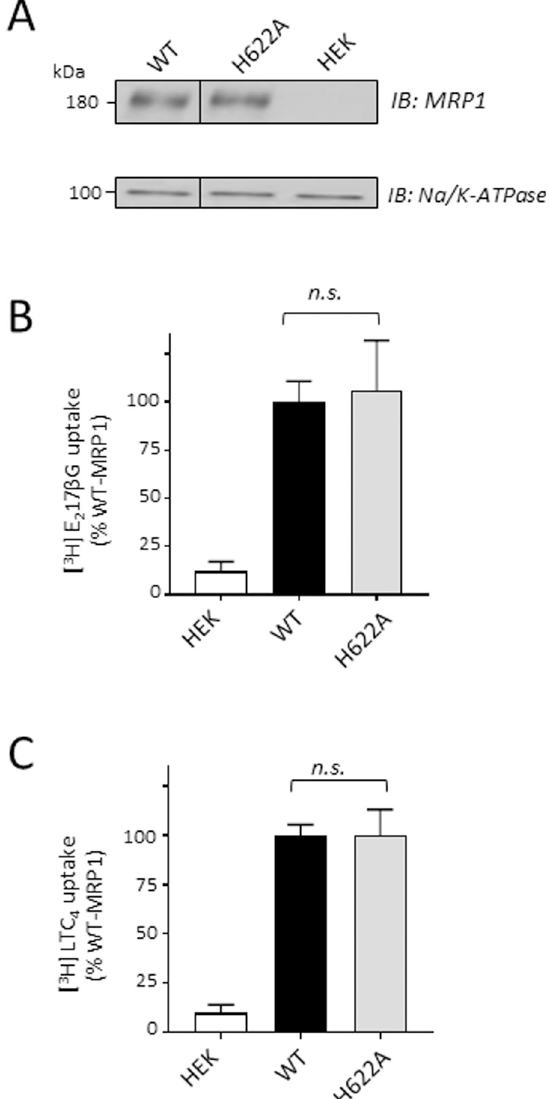
Fig 4. Ala substitution of CR1-His 622 has no effect on levels or organic anion transport activity of MRP1. (A) Shown is a representative immunoblot of inside-out membrane vesicles (1 μ g protein per lane) prepared from HEK cells transfected with wild-type (WT) and H622A MRP1 pcDNA expression vectors as well as untransfected cells (HEK) (negative control). The blot was probed for MRP1 (Mab QCRL-1) [54] and Na + /K + -ATPase as a loading control. The vertical black line indicates where irrelevant lanes from the immunoblot were removed by cropping the image. The images in each panel are from a single blot with the region between MRP1 and the loading control (Na + / K + -ATPase ) cropped out. (B & C) Transport activity was measured as ATP-dependent uptake of (B) [ 3 H]E 2 17 β G and (C) [ 3 H]LTC 4 into inside-out membrane vesicles and expressed as a percent of wild-type MRP1 uptake. The values shown have been adjusted to take into account minor differences in mutant MRP1 levels in the membrane vesicles relative to wild-type MRP1. Bars represent the mean values ( ± SD) of results obtained from three independent experiments. n . s ., not significant P > 0.05, unpaired t-test.